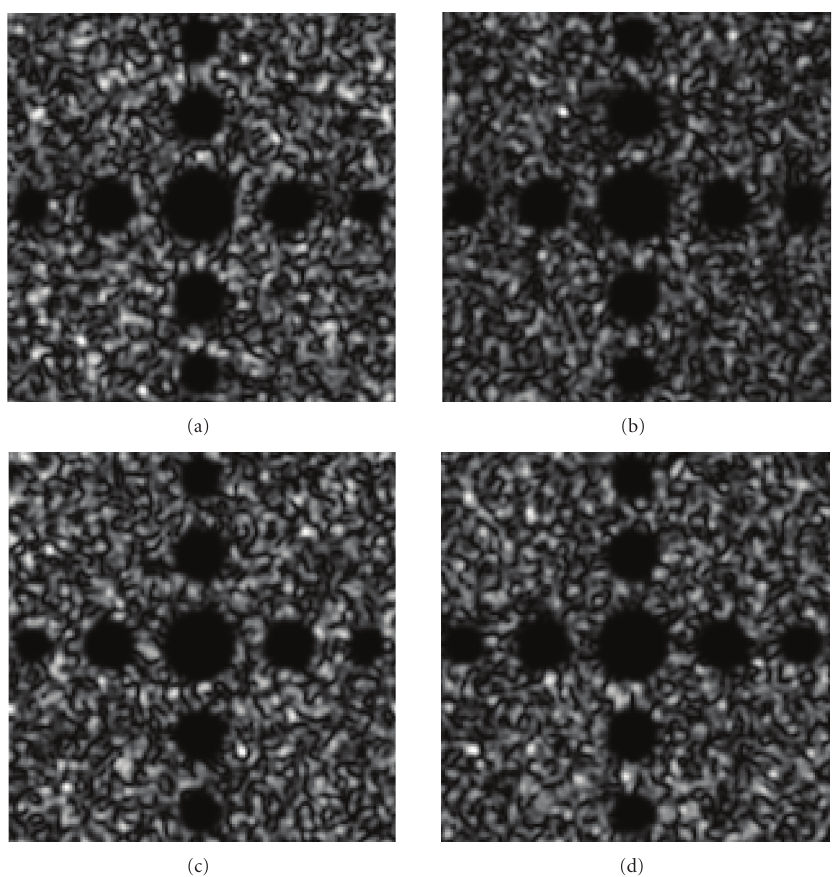
Figure 6: Two synthetic 3D ultrasound image sets I 1 and I 2 . I 1 and I 2 are imaged the same region but with di ff erent speckle pattern: (a) I 1 cross-sectional view, (b) I 1 sagittal view, (c) I 2 cross-sectional view, (d) I 2 sagittal